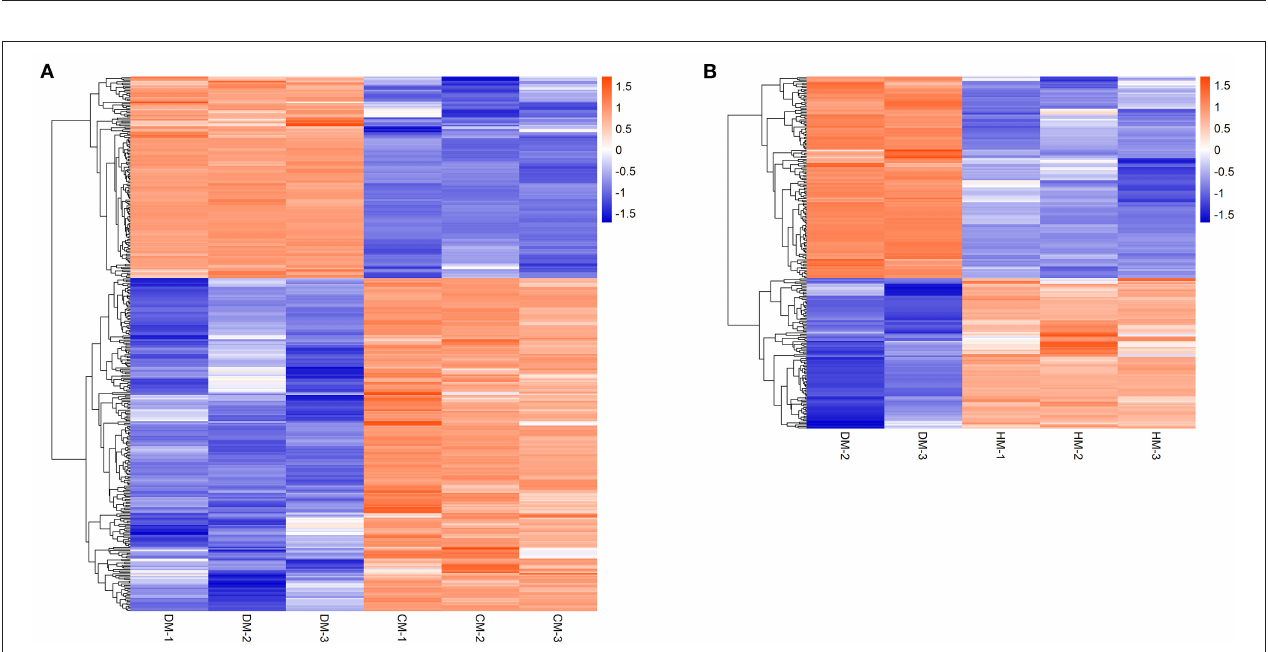
FIGURE 1 | Venn diagram of proteins identified from DM vs. HM group and DM vs. CM group. (A) Number of proteins quantitatively identified in DM vs. CM group. (B) Number of proteins quantitatively identified in DM vs. HM group.